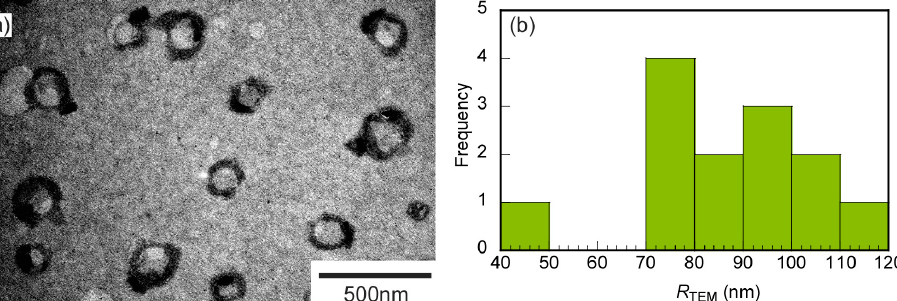
Figure 2. ( a ) TEM image and ( b ) histogram of particle size distribution for the P(VS) 17 A 50 /PAAc 49 PIC vesicle with f + = 0.5 at C p = 0.1 g/L in water at pH 10.